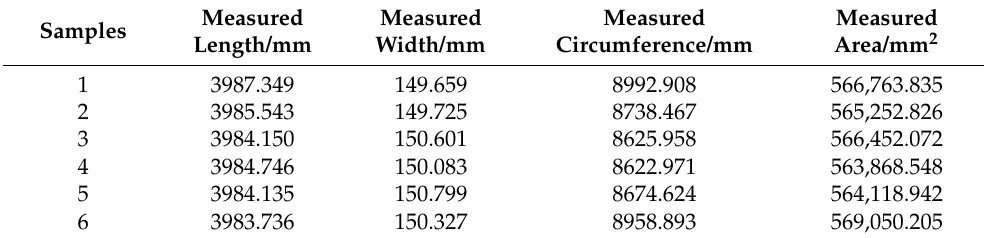
Table 3. Dimensional measurement of Pinus densiflora the dimension lumber.